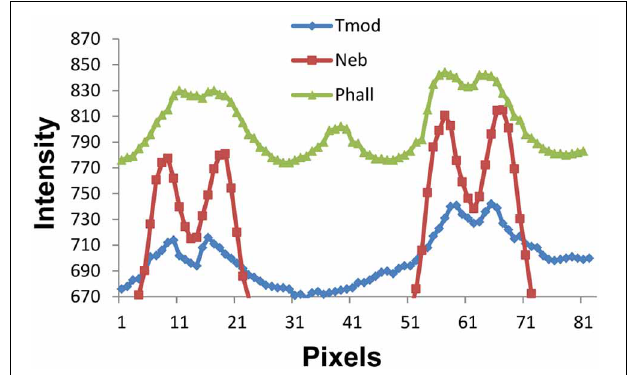
FIGURE 7 | Fluorescence staining intensity vs. pixel position plots for phalloidin, nebulin, and tropomodulin. The Z line position is near pixel 40 (see phalloidin pattern for Z line peak) and the 2minima between the nebulin, phalloidin, and tropomodulin doublets are at pixels ∼ 13–15 and ∼ 61–63, the centers of two adjacent sarcomeres. Note that the tropomodulin peak positions are 2–3 pixels farther from the Z line than those for nebulin, equivalent to 0.1–0.15 microns in